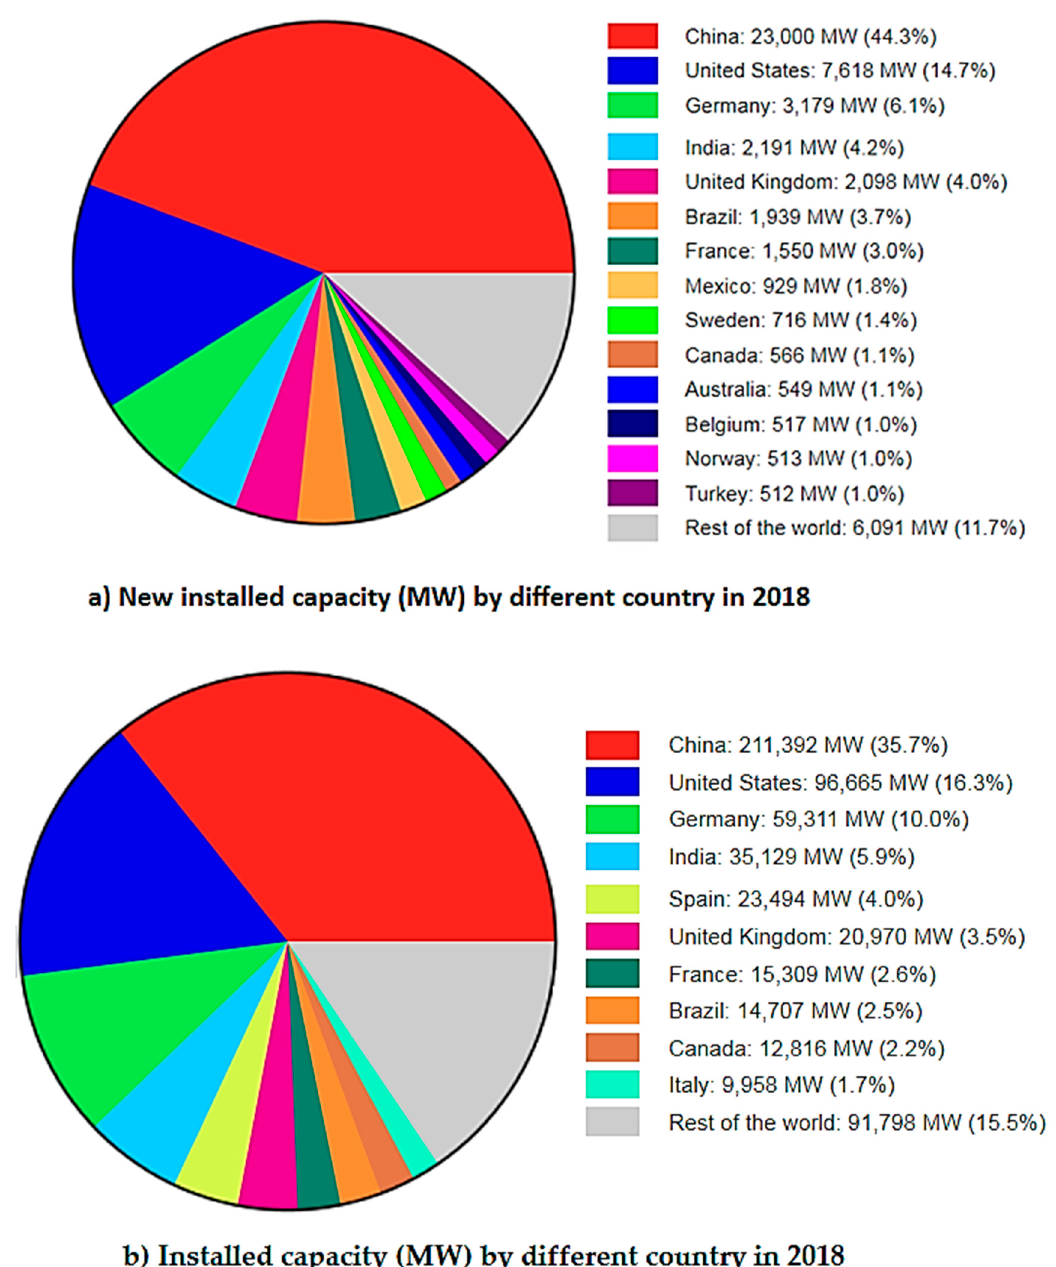
Figure 2. Cumulative installed capacity of wind energy in the world end-of-year by 2018 and newly added capacity by different country in 2018 [4].